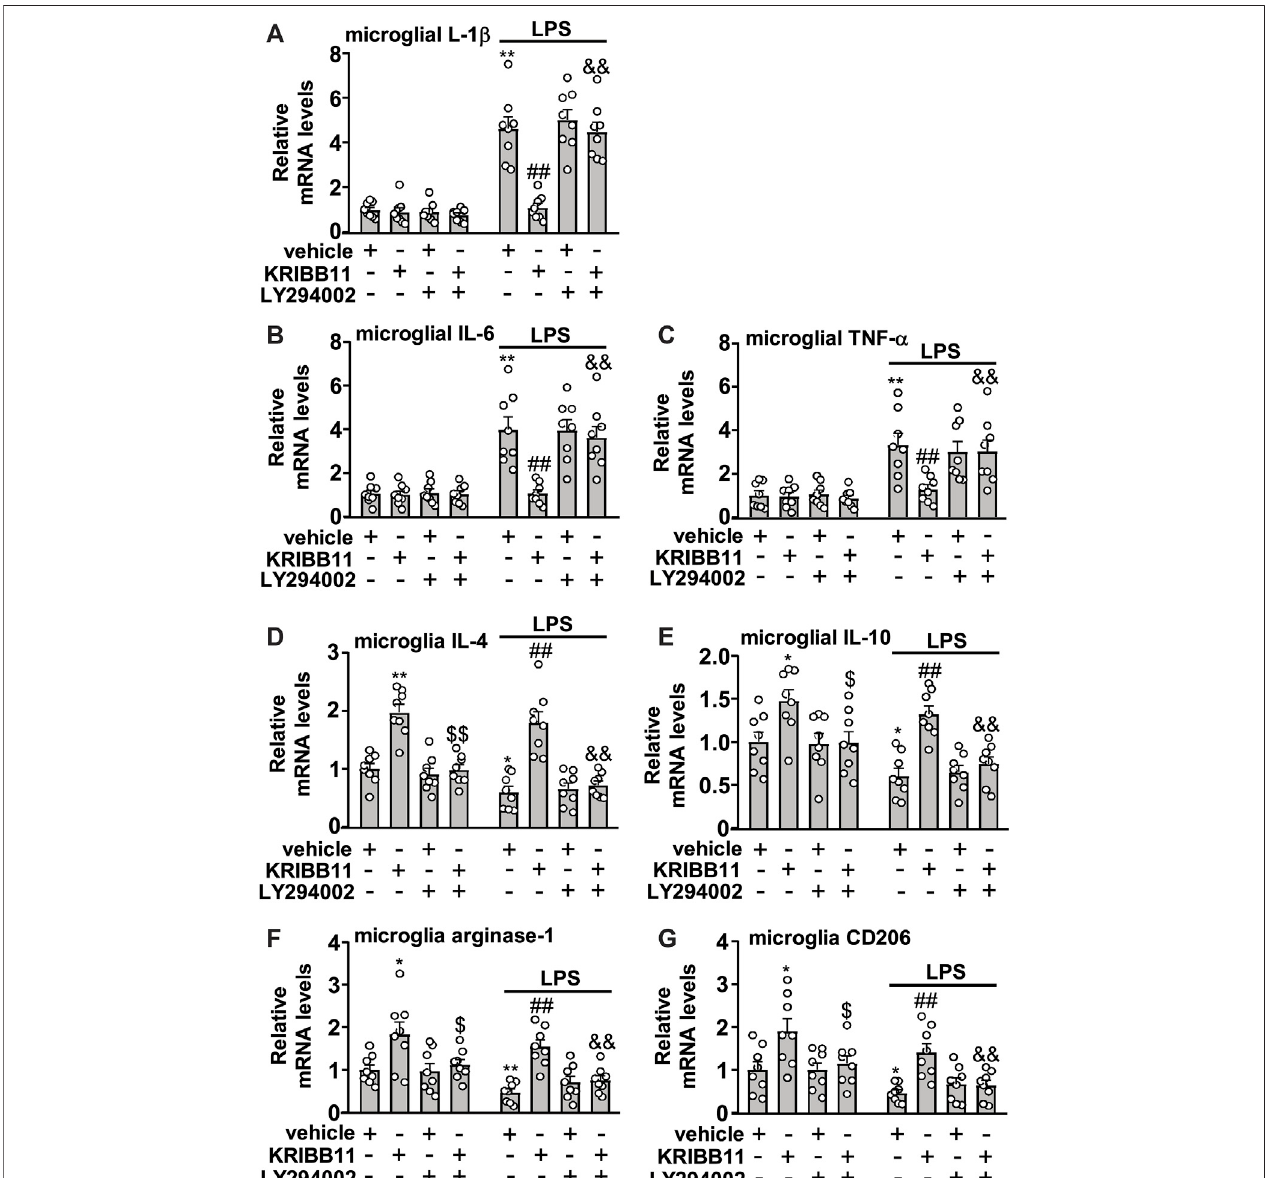
FIGURE 7 | Akt inhibition abrogates the preventive effect of KRIBB11 on LPS-induced in fl ammatory responses in primary cultured microglia. (A ‒ C) Quantitative analysis showed that LY294002 pretreatment (20 μ M, 30 min) abrogated the preventive effect of KRIBB11 on LPS-induced increases in the expression levels of IL-1 β (A) , IL-6 (B) , and TNF- α (C) mRNA in primary cultured microglia ( n = 8, ** p < 0.01 vs. vehicle, ## p < 0.01 vs. vehicle + LPS; && p < 0.01 vs. KRIBB11 + LPS). (D ‒ G) Quantitative analysis showed the abrogation effect of LY294002 pretreatment (20 μ M, 30 min) on KRIBB11-induced increases in the expression levels of IL-4 (D) , IL-10 (E) , arginase-1 (F) , and CD206 (G) mRNA in primary cultured microglia treated with or without LPS ( n = 8, * p < 0.05 or ** p < 0.01 vs. vehicle, $ p < 0.05 or $$ p < 0.01 vs. KRIBB11, ## p < 0.01 vs. vehicle + LPS; && p < 0.01 vs. KRIBB11 + LPS). Data are shown as mean ± SEM.